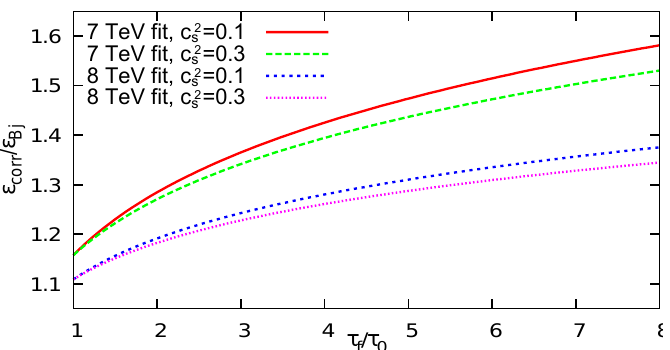
Figure 2. The correction factor as a function of freeze-out time versus thermalization time ( τ f / τ 0 ). At a reasonable value of 2, the correction factor is around